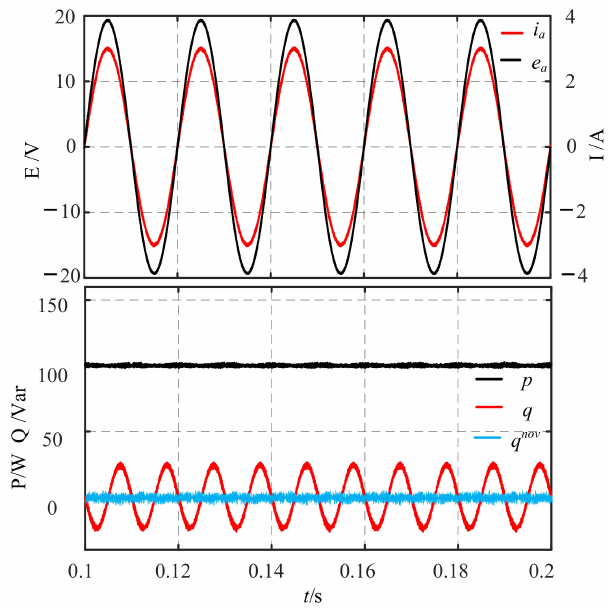
Figure 8. Instantaneous power and new instantaneous power waveform.